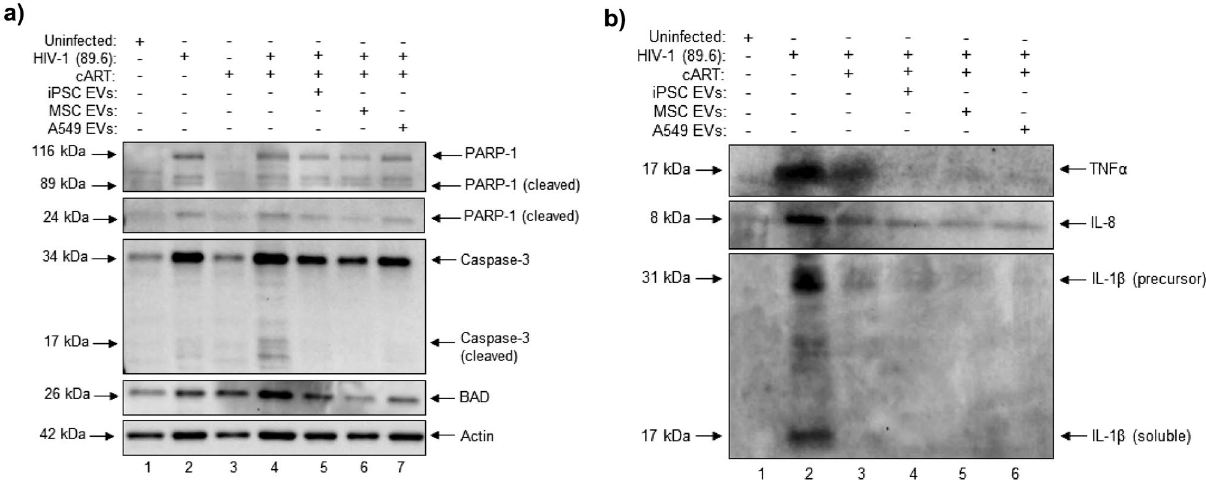
Figure 5. The effect of EVs on HIV-1 infected neurospheres. Differentiated neurospheres were exposed to dual- tropic HIV-1 89.6 with or without cART (lamivudine, tenofovir disoproxil fumarate, emtricitabine, indinavir) for a period of fourteen days. Additionally, the HIV-1 + cART treated samples were treated with either iPSC, MSC, or A549 EVs at an approximate ratio of 1:250 (recipient cell to EV ratio). (a) Western blot was performed on neurosphere lysates to evaluate the relative expression of PARP-1, Caspase-3, and BAD. (b) Western blot was performed on neurosphere supernatants to evaluate the relative expression of TNFα, IL-8, and IL-1β.